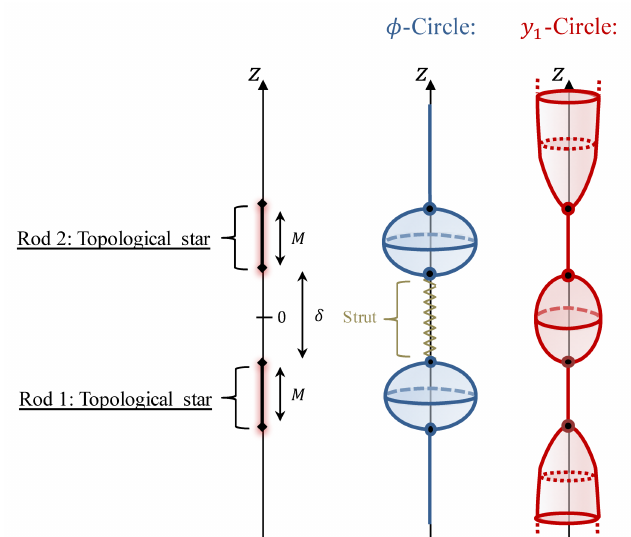
Figure 3. Rod profile of a solution with two topological stars and the behavior of the circles on the z